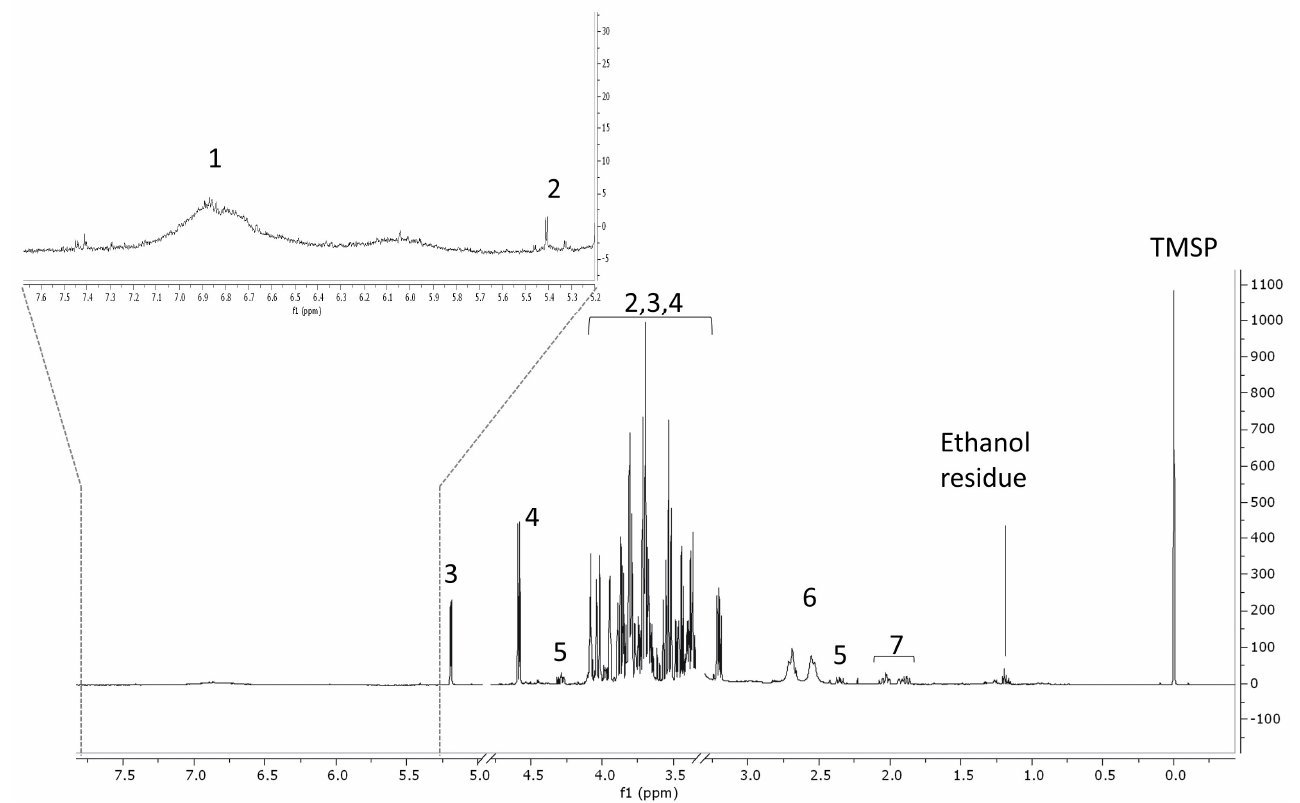
Figure 1. 1 H − NMR profiling of RCL extract. 1 = aromatic compounds, 2 = sucrose, 3 = α − glucose, 4 = β − glucose, 5 = malic acid, 6 = citric acid, 7 = quinic acid. TMSP = tetramethylsylilpropionic acid (internal